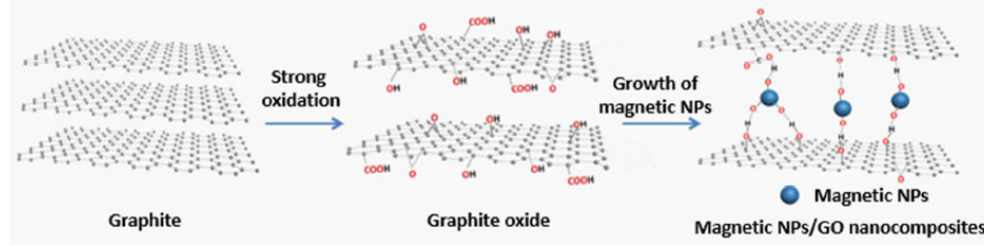
Figure 5. Hydrothermal synthesis of magnetic graphene oxide (mGO) via impregnation of Fe 3 O 4 particles on the surface of GO flakes (Reproduced or adapted ref. [27] , with permission from Royal Society of Chemistry).